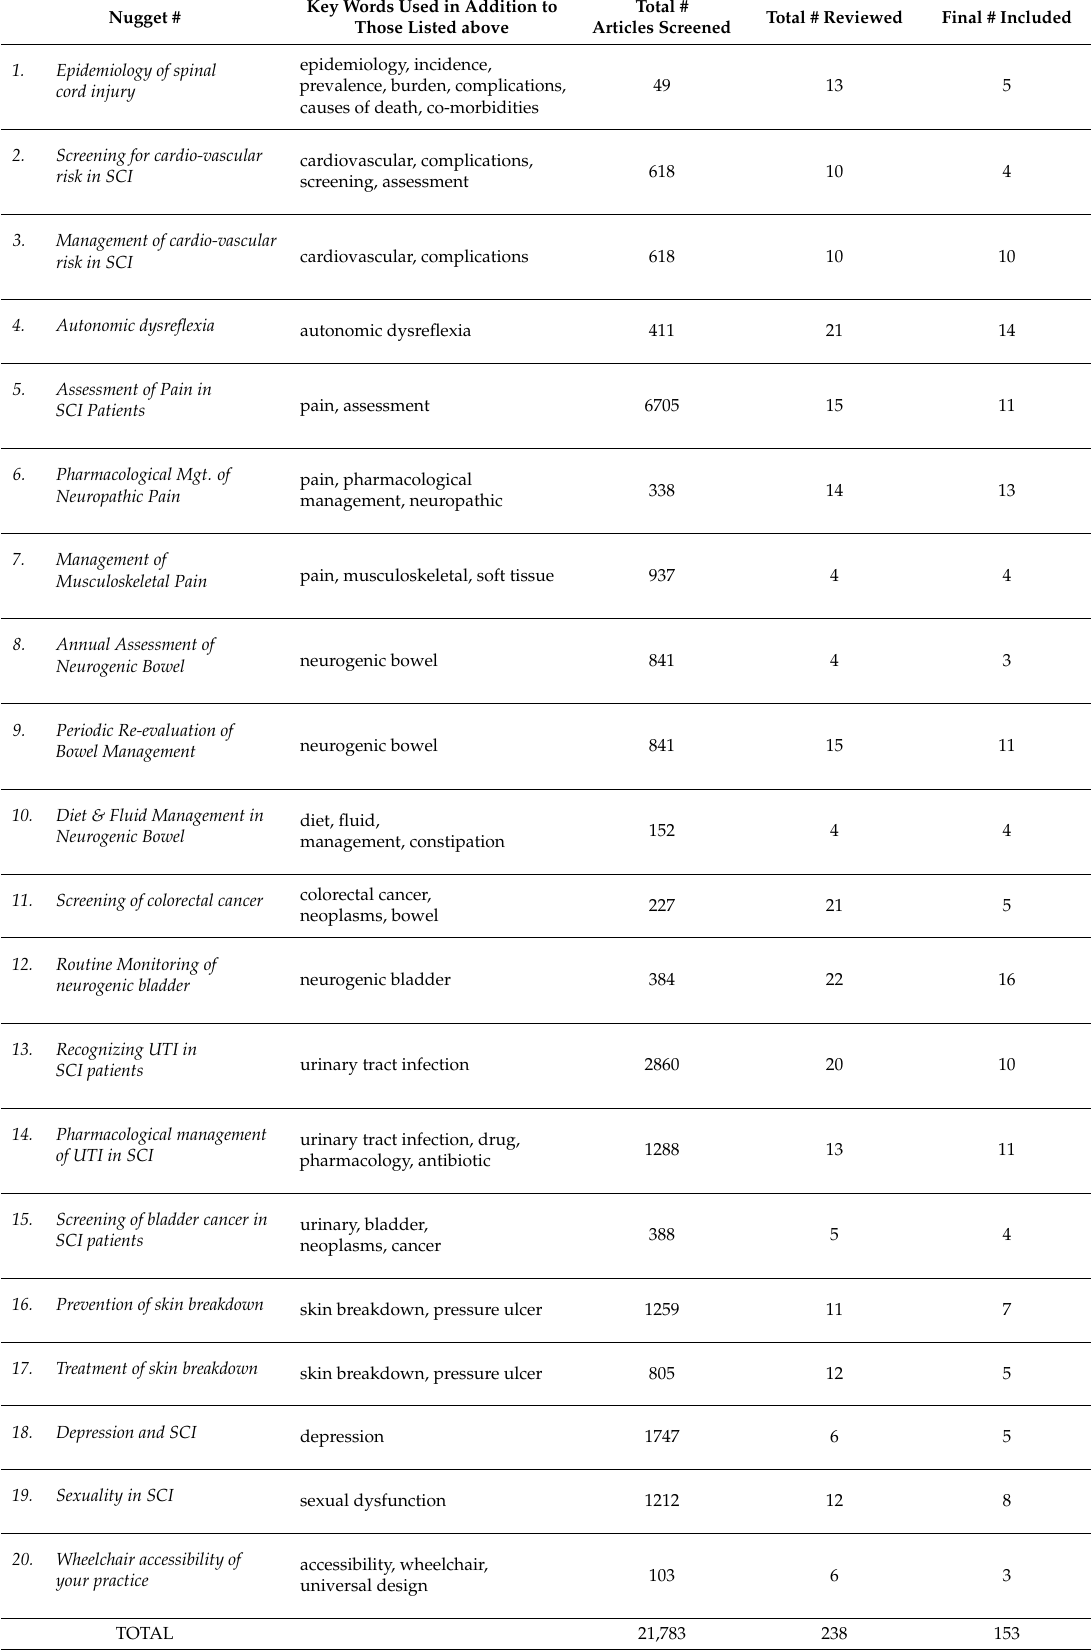
Table 1. List of Nuggets and keywords used for scoping